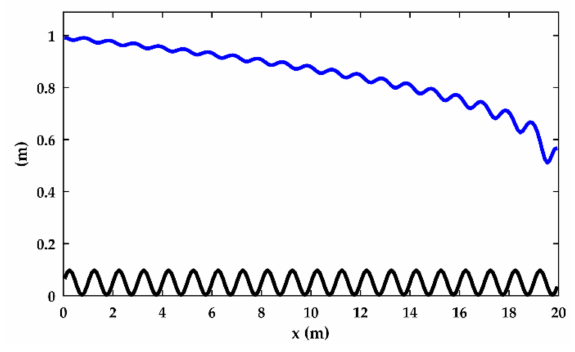
Figure 8. Hydraulic solution for test 3. Table 3. Summary of the 5 tests used to investigate the best parameters for the new